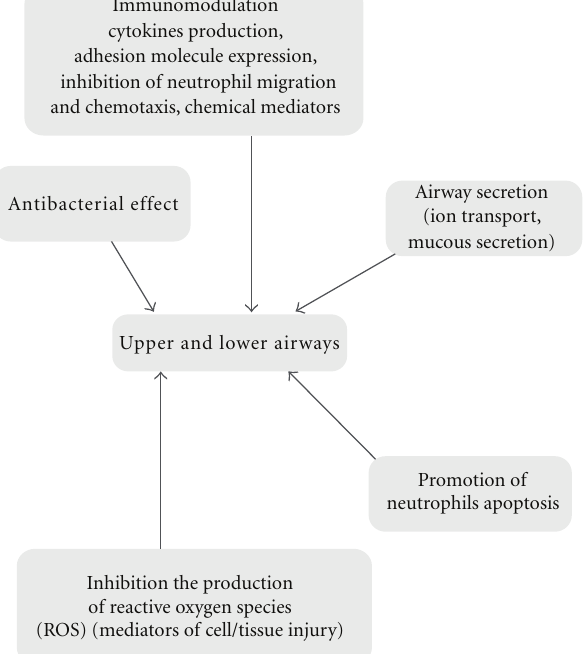
Figure 2: Macrolides influence on inflammatory airway diseases.